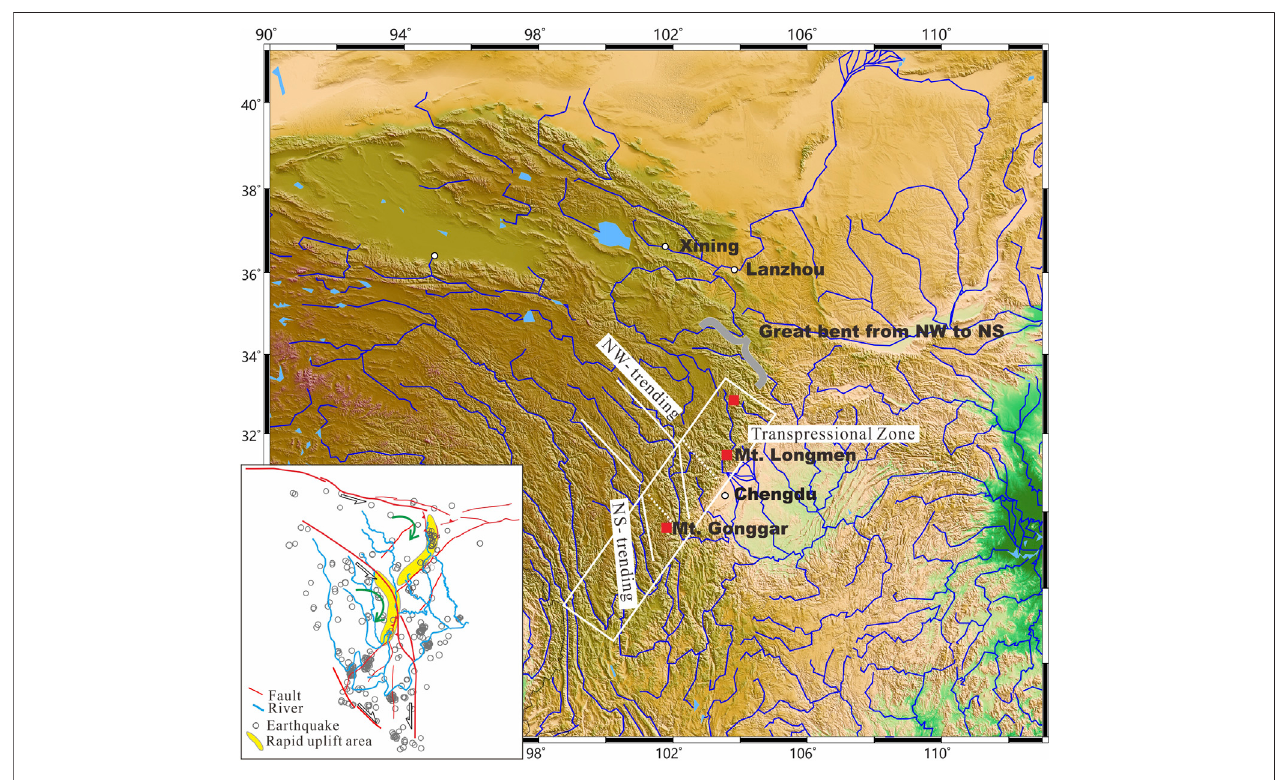
FIGURE2| CharacteristicsofthecontinentaltranspressionalzoneintheeasternmarginoftheTibetanPlateau.Whitedotsdenotethemaincitiesinthisregion.The insert map in the lower-left corner shows the fault systems, river systems, and past earthquakes of eastern margin of the Tibetan Plateau.